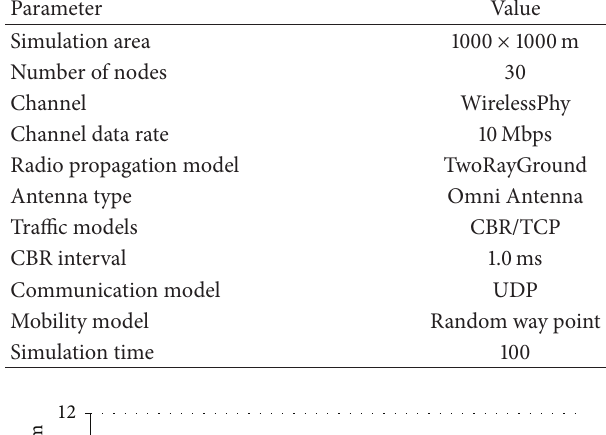
Figure 11: Packet Delivery Rate of TMUR, L&TS, and ACFG.